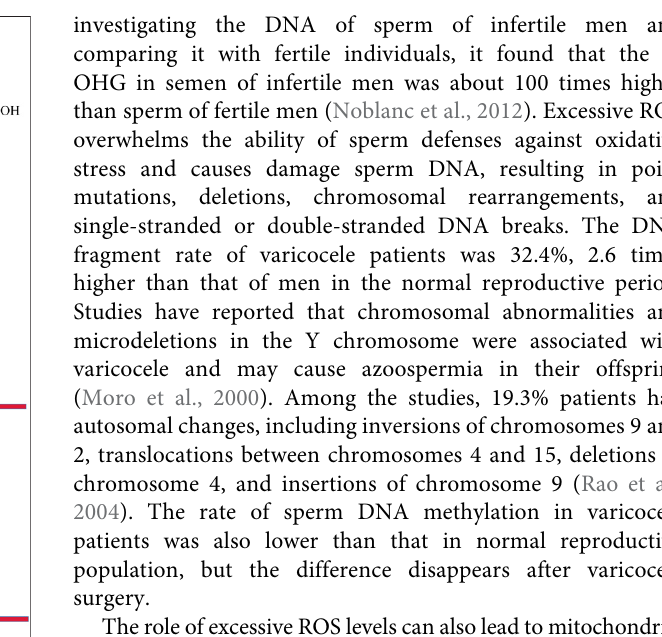
Frontiers in Genetics |